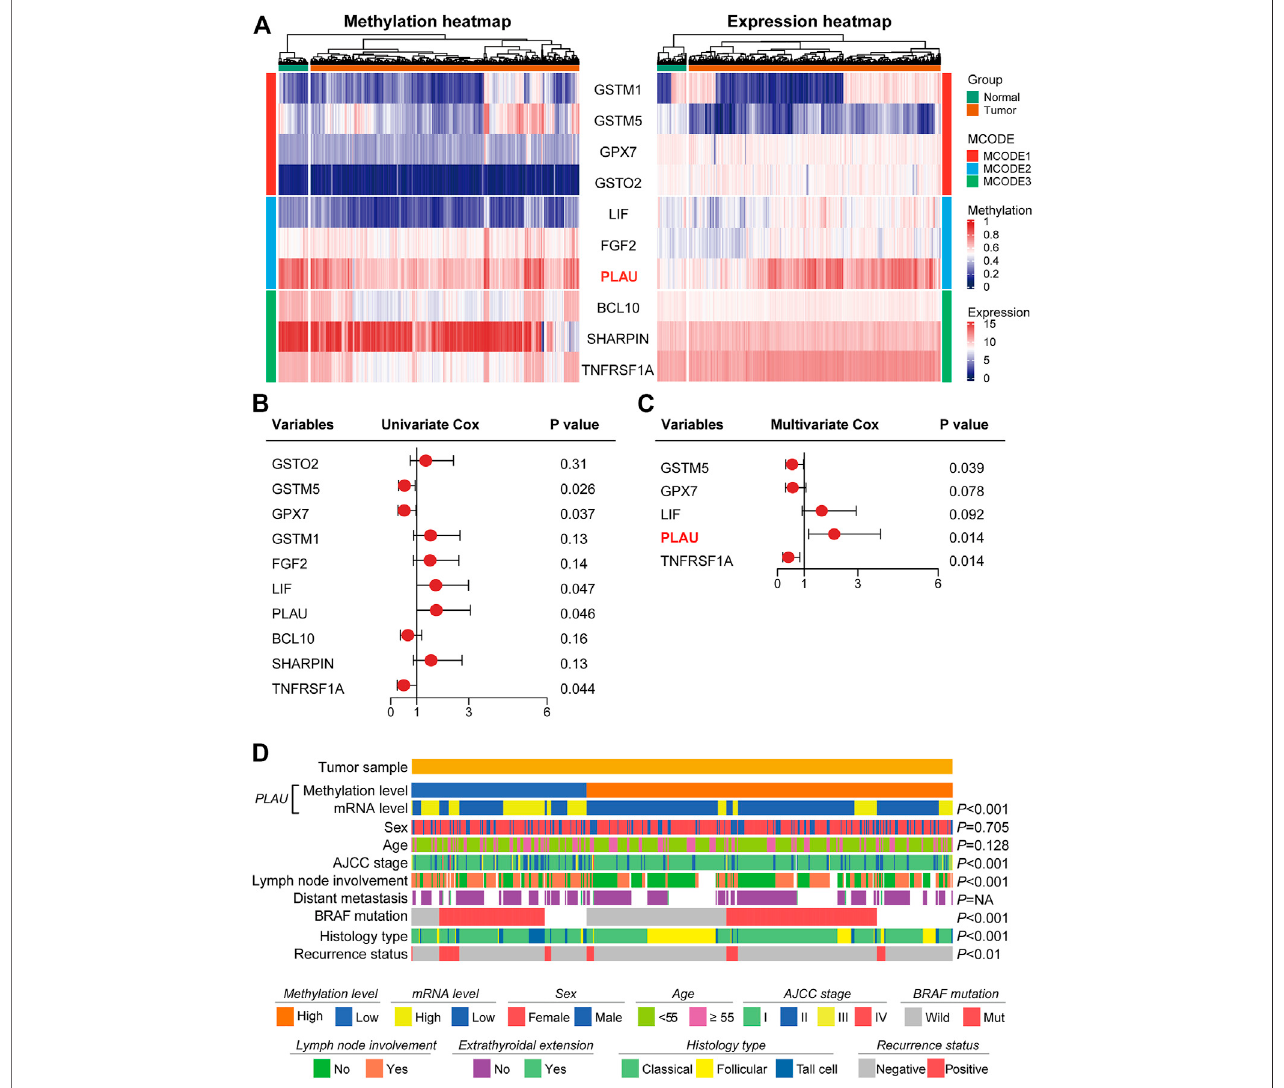
FIGURE 2 | Methylation levels of PLAU correlated with the clinicopathological characteristics in THCA patients. (A) Heatmap showing the methylation pro fi le and transcriptome pro fi le of ten Hub genes. (B – C) Univariate Cox regression and multivariate Cox regression analysis identi fi ed PLAU as a signi fi cant risk factor for recurrence. (D) Association of the methylation levels of PLAU with the clinicopathological features in THCA patients.